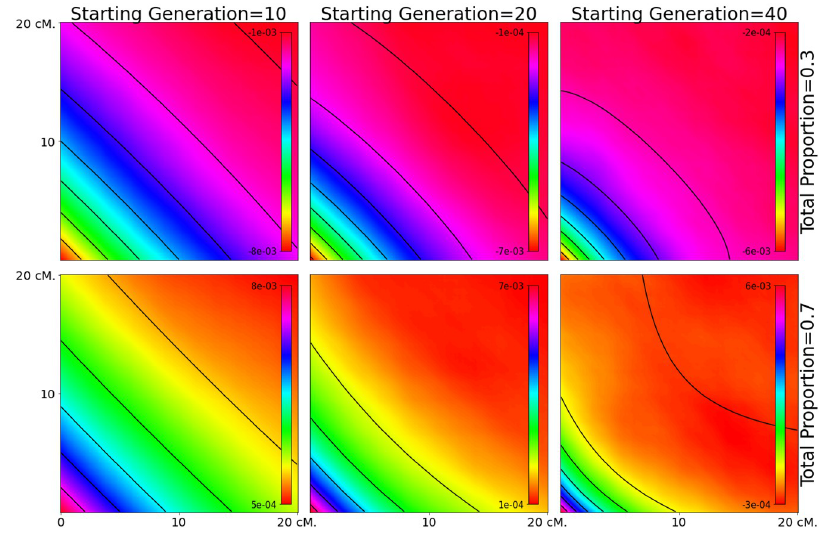
Fig 3. Weighted LD surfaces produced by constant admixture. The heat maps are from simulations and the contours from analytical results for a model in which continuous admixture started 10, 20, or 40 generations ago and stopped 5 generations before the present. Each square covers the range 0.5 cM < d , d 0 < 20 cM. We varied the time of the beginning of the admixture and the total admixture probability. The admixture probability for each generation was constant, and chosen so that the total admixture proportion was either 0.3 or 0.7. When the admixture is spread over 5 generations (the leftmost column), the resulting weighted LD surface is similar to a one-pulse weighted LD surface. For longer durations, the weighted LD surfaces are similar to those produced by two pulses of